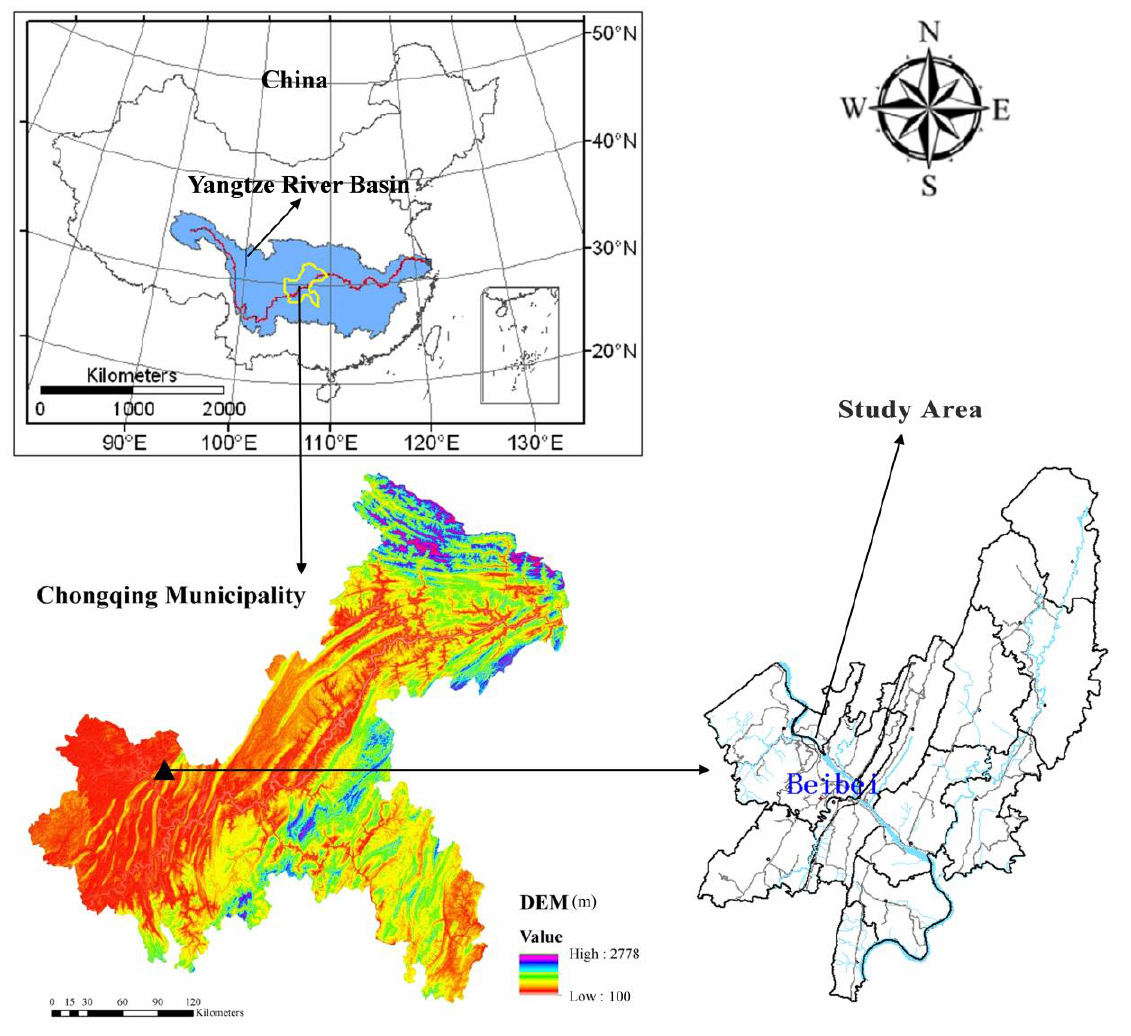
Figure 1. The study area. Table 1. The properties of the test soils in the experiment